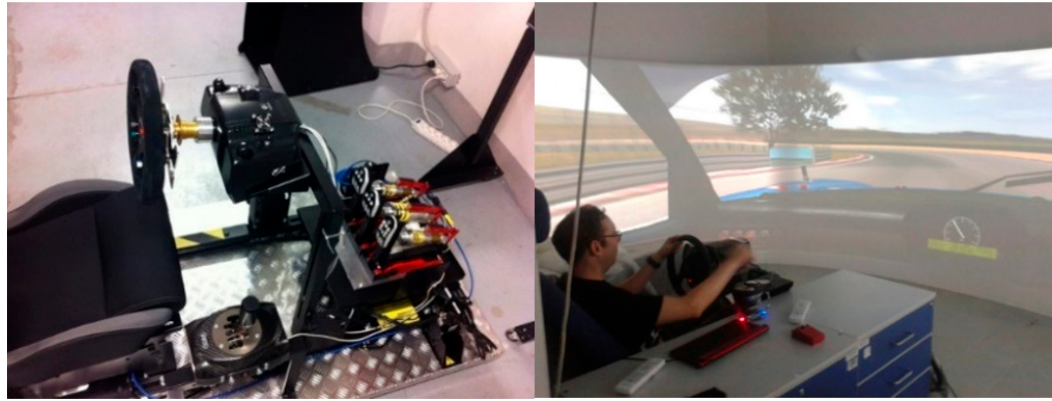
Figure 1. Moving platform and display system.